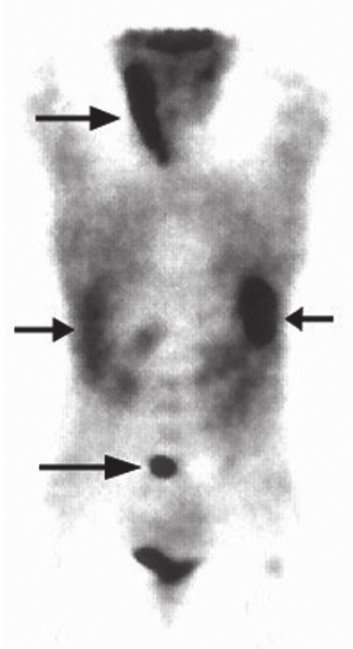
Figure 1 - Staging with CGC-PET with FDG. A 23 year-old female, who after physical examination, CT and bone marrow biopsy was regarded as having stage I disease (only right cervical lymph nodes enlargement). CGC- PET (coronal plan) demonstrated abnormal glucose metabolism (black arrows) in right cervical region, spleen, liver and lumbar spine (stage IV disease). Staging laparotomy confirmed the presence of disease in the abdominal sites (spleen and